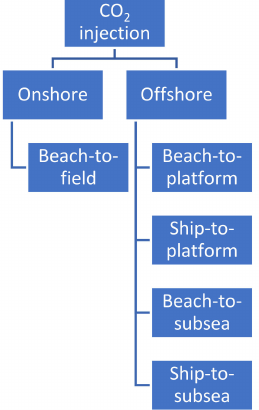
Figure 10. Development concepts for CO 2 -injection.